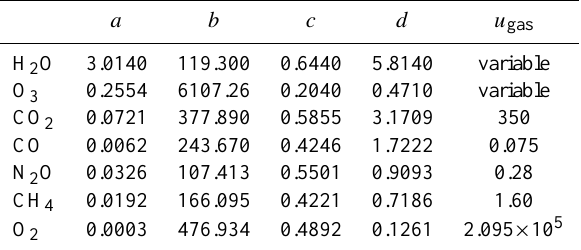
Table 1. Coefficients a , b , c and d used to compute shortwave transmittances for predominant atmospheric gases using Eq. (6). The amount of each atmospheric gas ( u gas ) considered in SIRAMix is also given. All values are taken from Psiloglou and Kambezidis (2007) and Psiloglou et al.